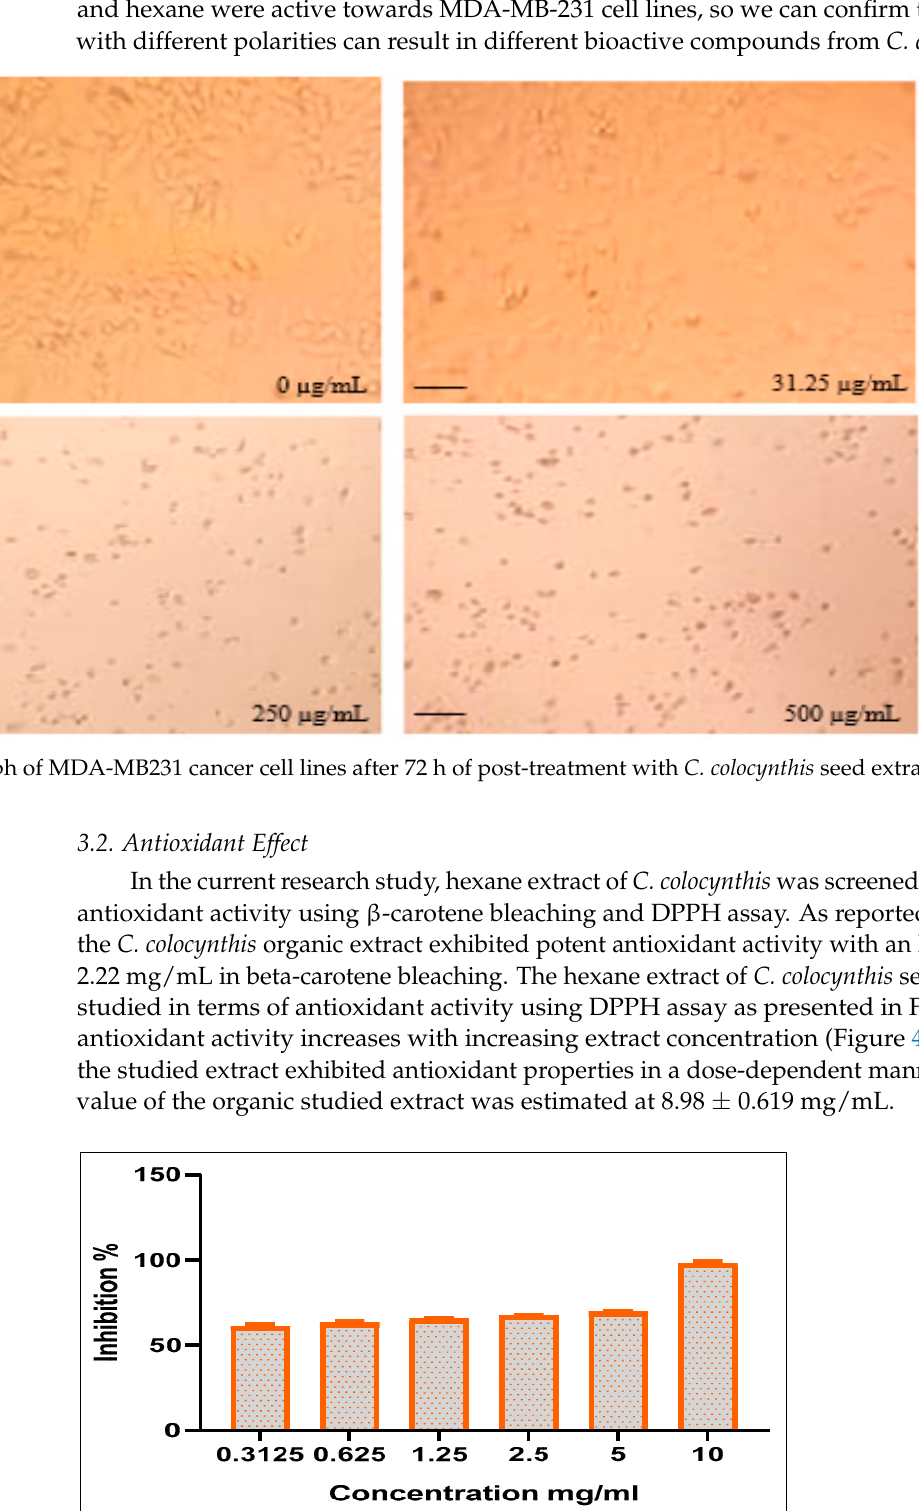
Figure 4. Scavenging activity of C. colocynthis hexane extract using DPPH assay. The antioxidant activity of C. colocynthis seed extract effect was found more im- portant. It is thus fitting that the present findings were in agreement with earlier work that reported free radical scavenging effects of C. colocynthis [27] . Many researchers have attributed the antioxidant property of C. colocynthis extract to the flavonoids content in its seeds and fruits, i.e., isosaponarin, isovitexin, and isoorientin3-O-methylether isolated from C. colocynthis possessed an important antioxidant activity with an IC 50 value ranging from 5.62 × 10 − 4 to 7.13 × 10 − 2 mg/mL [28]. The reported findings in the current work were in accordance with earlier literature, which investigated the scavenging activity of C. col- ocynthis hexane extract [29]. 3.3. Antibacterial Activity The antibacterial effect of the tested extract varied as a function of the target micro- organism. The studied extract did not affect Gram-negative bacterial strains whilst the hexane extract generated a clear growth inhibition zone on E. faecalis 471 strains with a diameter of inhibition zone reaching 3 mm (Gram-positive). However, S . a ureus as a Gram-positive was not sensitive to the C. colocynthis extract. Bacterial infections have presented a great challenge because of the eventual re- sistance of bacteria to modern drugs, hence the development of alternative drugs remains one of the most effective solutions to mitigate the extensions of bacterial infections. Desir- ing to contribute to the bacterial infection palliation, we tested C. colocynthis for its poten- tial antibacterial activity in the current study. In this sense, the tested seed extract of C. colocynthis was active on some positive bacterial strains such as E. faecalis 471 and L. mon- ocytogenes . However, no effect was observed on Gram-negative bacteria nor S. aureus . These findings were in agreement with previously reported studies, which highlighted a poor effect of C. colocynthis ethanolic extract on Gram-negative bacteria [30]. However, the aqueous and acetone extracts of C. colocynthis were active on both Gram-positive and